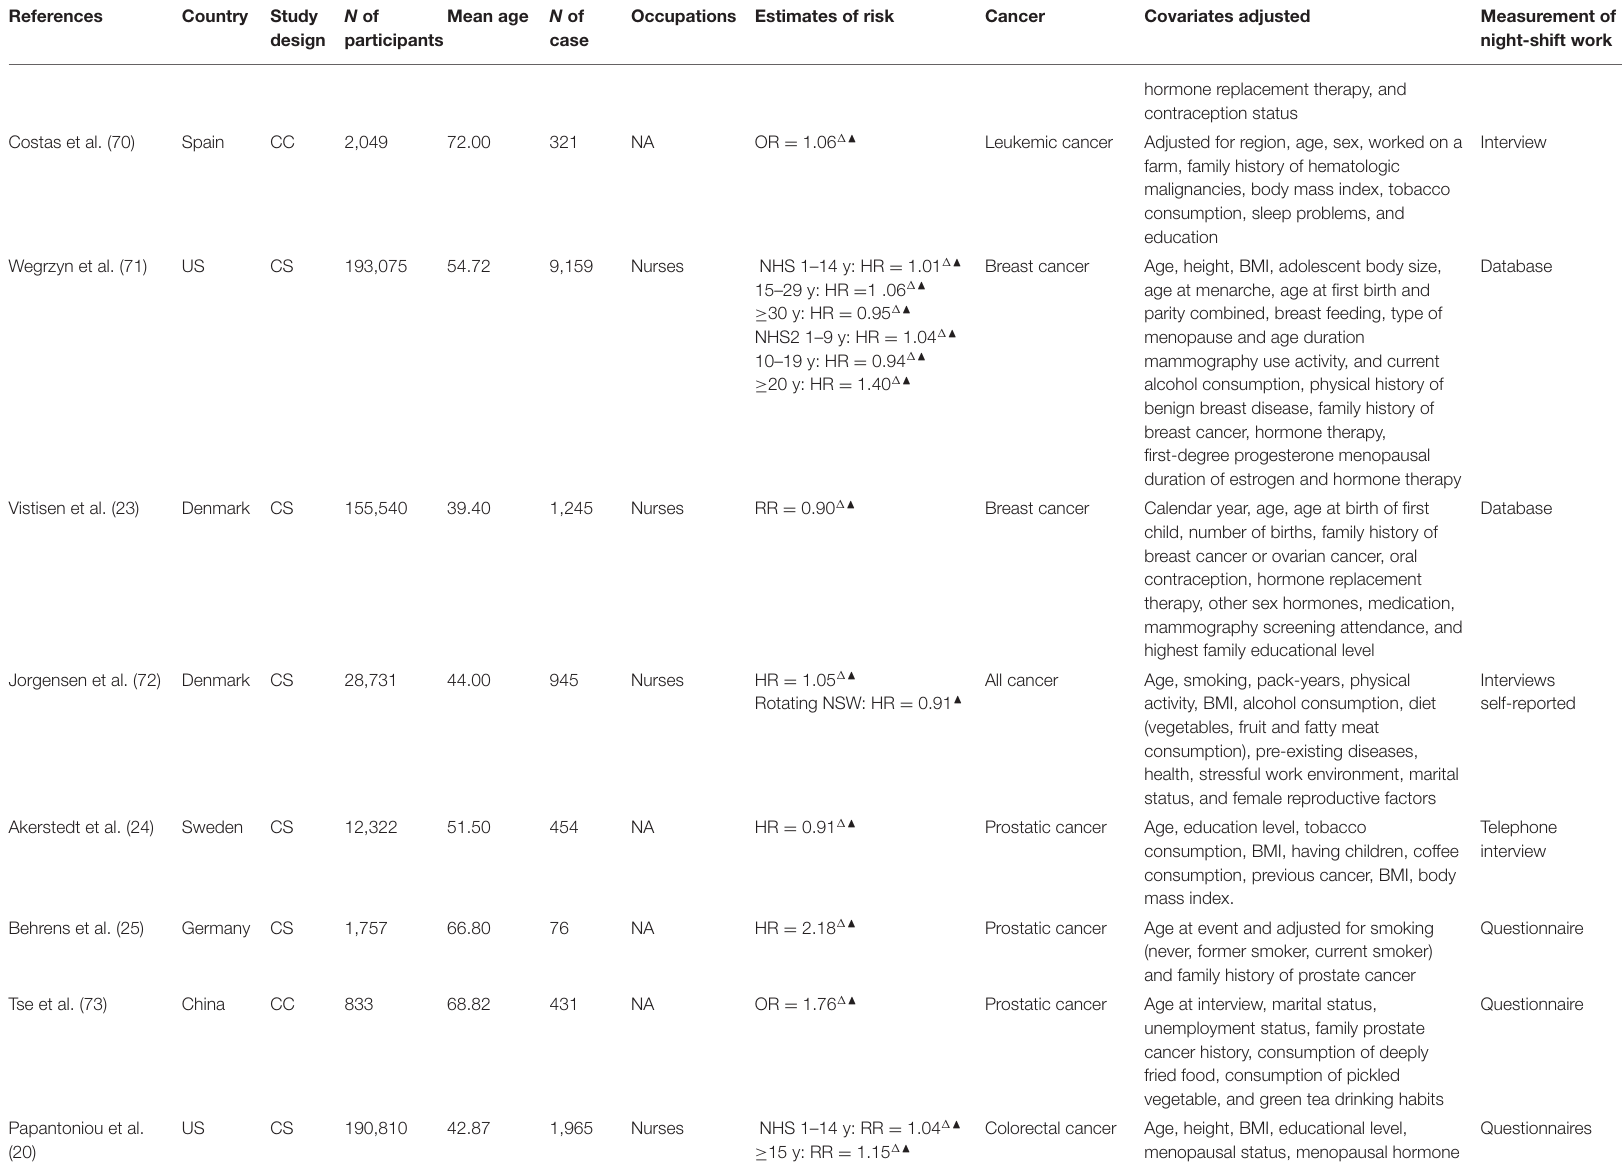
Rotating NSW: HR = 0.91 N